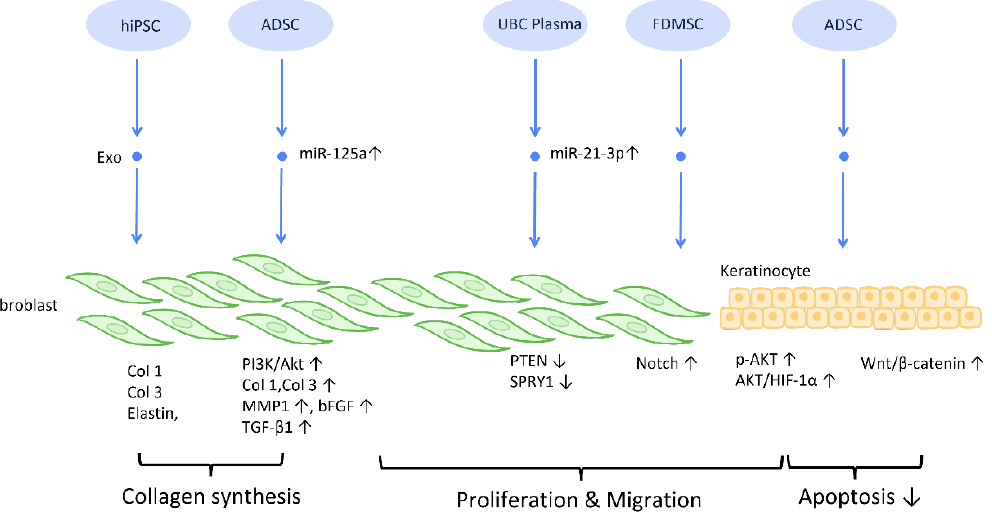
Figure 3. Molecular mechanisms of stem cell-derived exosomes in regulation of fibroblast and keratinocyte. Stem cell-derived exosomes enhance the proliferation and collagen synthesis of fibroblasts, thereby improving the healing process. ADSCs are also shown to accelerate keratinocyte migration and proliferation, which contributes to augmented healing activity. Abbreviation: Exo: exosome; Col: collagen; MSC: mesenchymal stem cell; ADSC: adipose-derived stem cell; miR: micro-RNA; TGFβ: transforming growth factor- β; PI3K/Akt: phosphatidyl-inositol 3-kinase/serine-threonine kinase; MMP: matrix metalloproteinase. ↑ represents upregulation; ↓ represents downregulation.